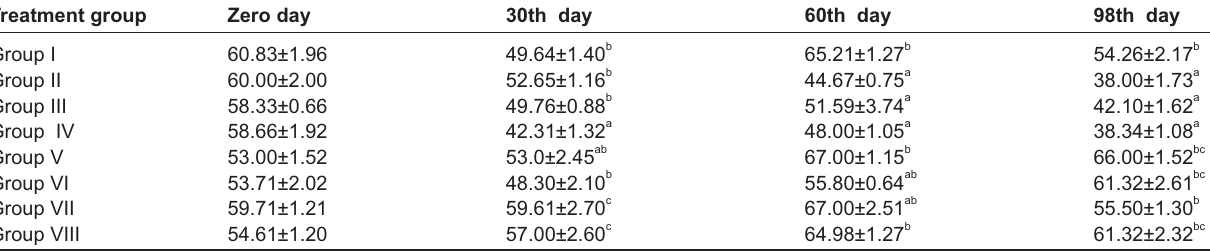
Table-4. Effect of oral administration of chlorpyriphos, lead acetate, vitamin C alone, and in combinations on blood c atalase activity (ìmole H O decomposed/min/mg protein) in rats. 2 2 Treatment